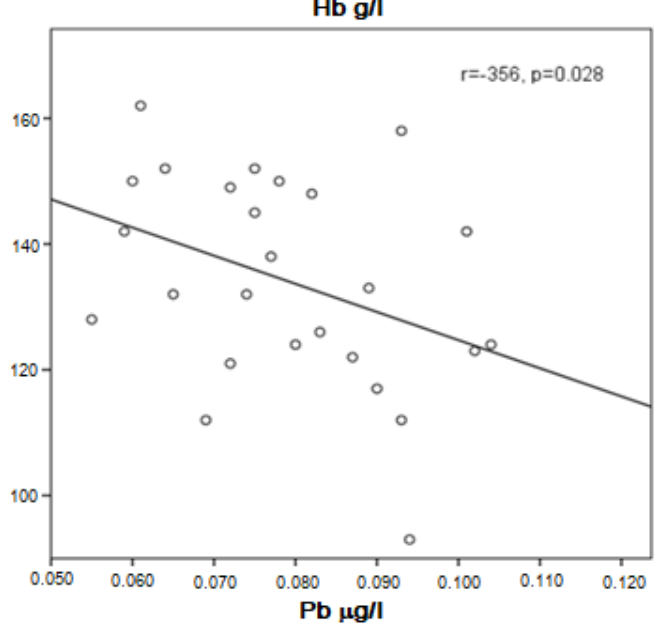
Figure 3. Correlation of Pb and hemoglobin in COPD patients.